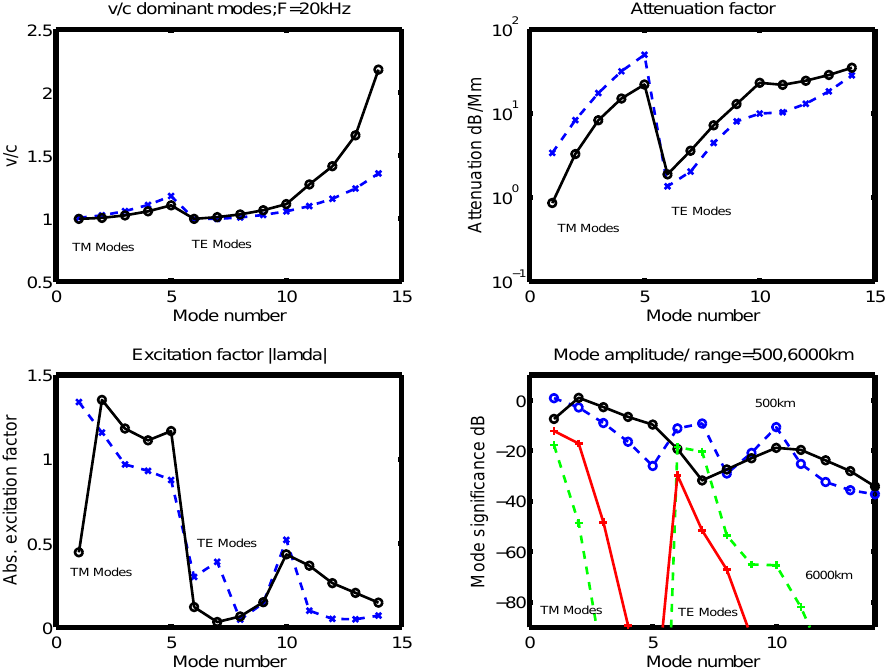
Fig. 2. Modal parameters at f =20kHz for the profile given by h 0 =80km, β =0.5km − 1 . The solid lines are for the unperturbed profile, the dashed blue lines for the profile with biteout. The fourth panel shows modal amplitudes at the receiver at a range of 500 km, the black line with circles being with no biteout, the blue line with circles with biteout. The corresponding figures at a range 6000km are given by the dashed green line with crosses (biteout) and red line with crosses (no biteout).